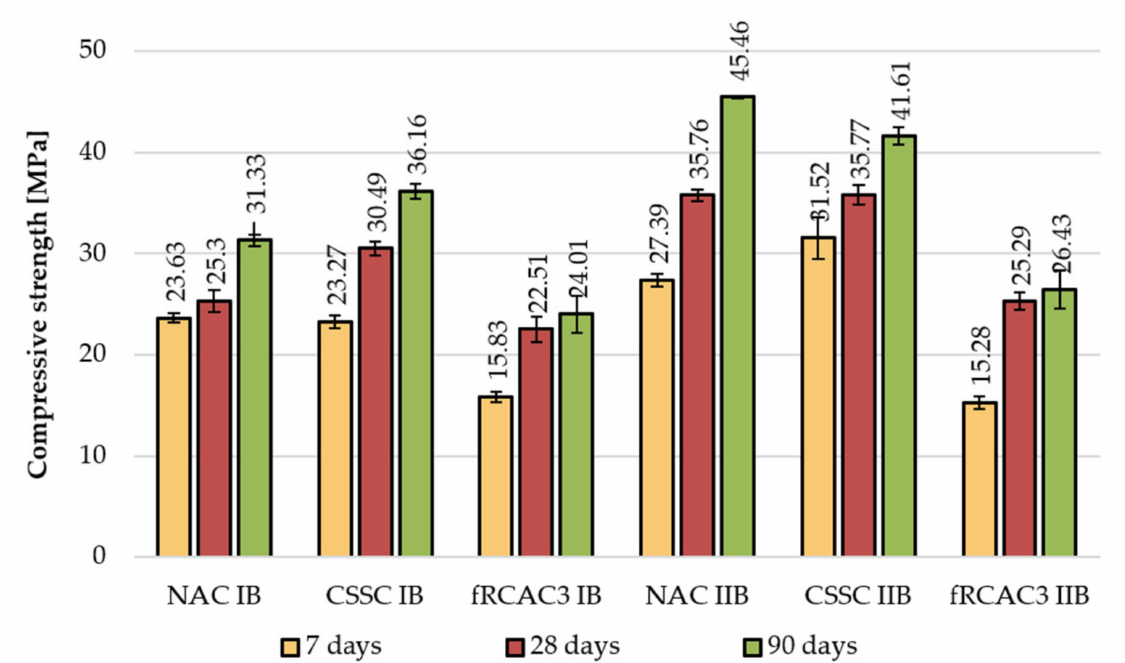
Figure 7. Comparison of long-term development of compressive strength of concrete